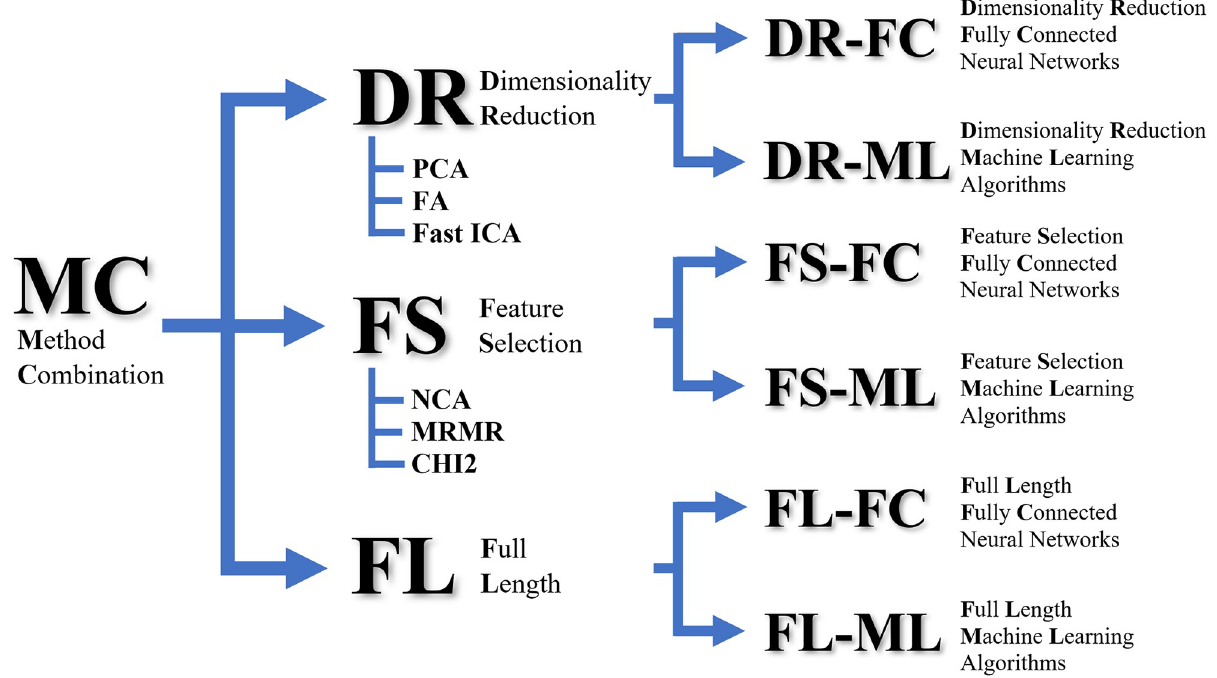
Fig 7. A tree diagram depicting the method combination used in this